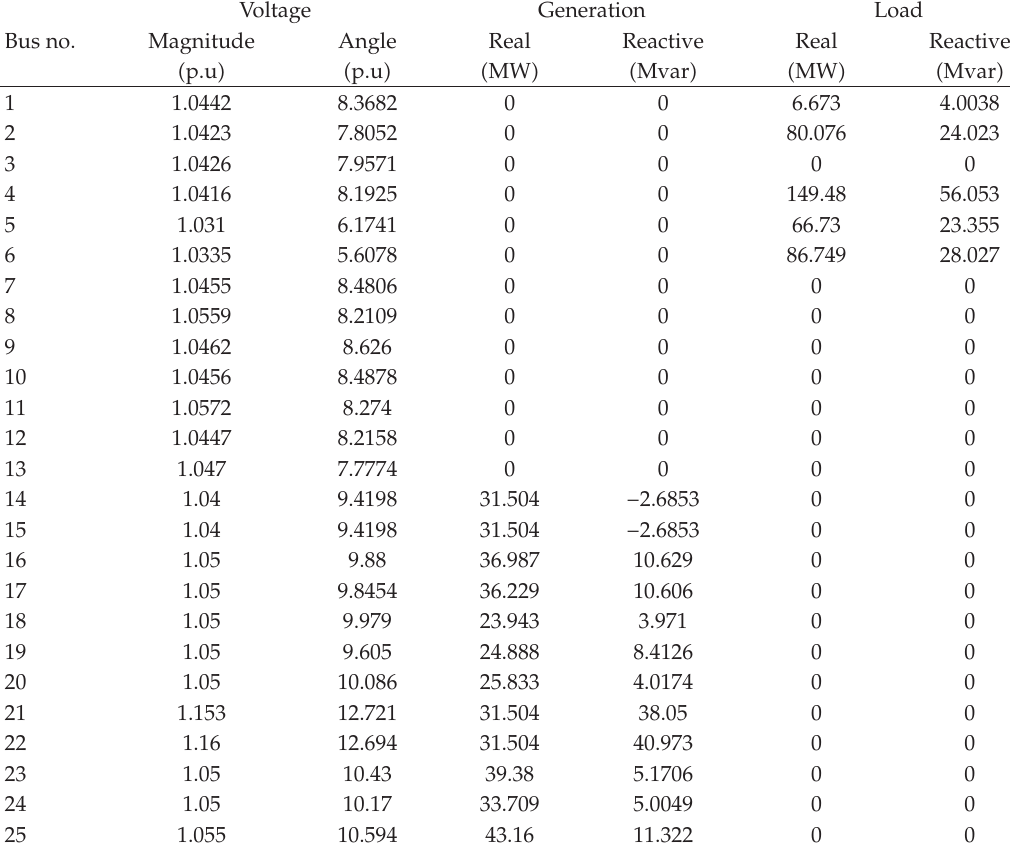
Table 3: Load flow data for the 25-bus equivalent system at hour